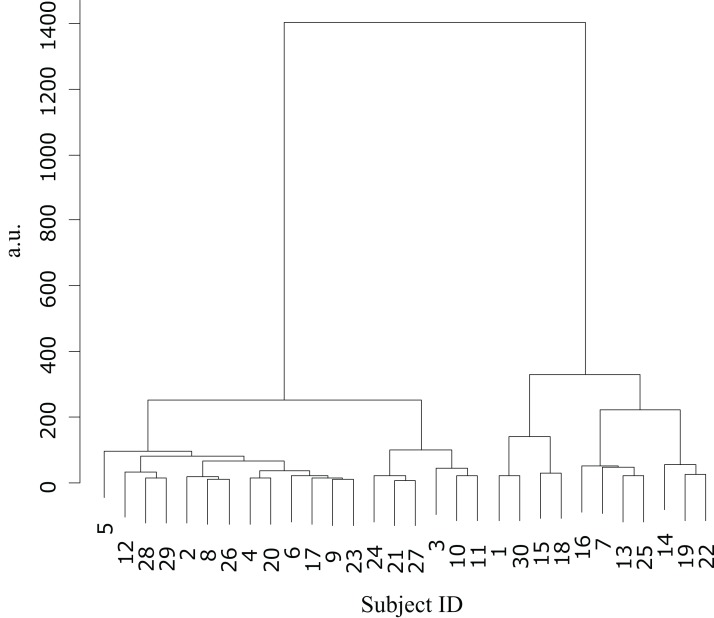
Cluster analysis.Dendrogram based on the cluster analysis generated using Ward’s method, wherein the error values from the first and final sets were used as variables. The participants were subsequently divided into two clusters.